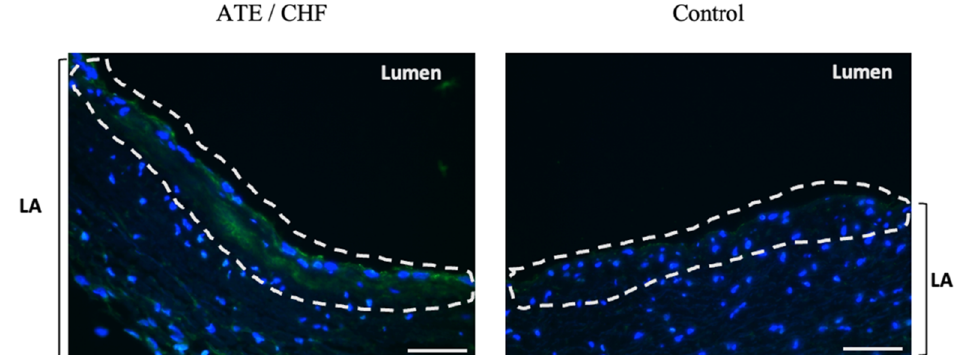
Figure 2. Localisation of vWF in the endocardium. Immunostaining of vWF in the endocardium. On the left, endocardial vWF (green) in a cat with cardiomyopathy and clinical signs. On the right, minimal endocardial immuostaining of vWF in a control cat. 400× magnification, Bar = 50 µm.